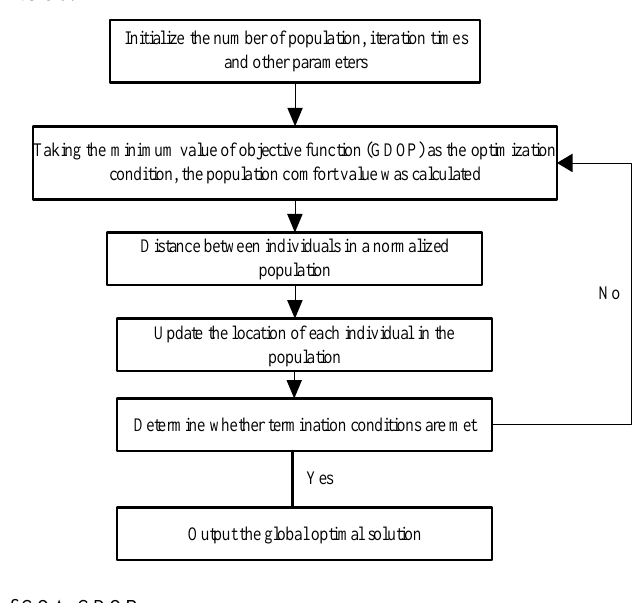
Fig. 1 Flow chart of GOA-GDOP.